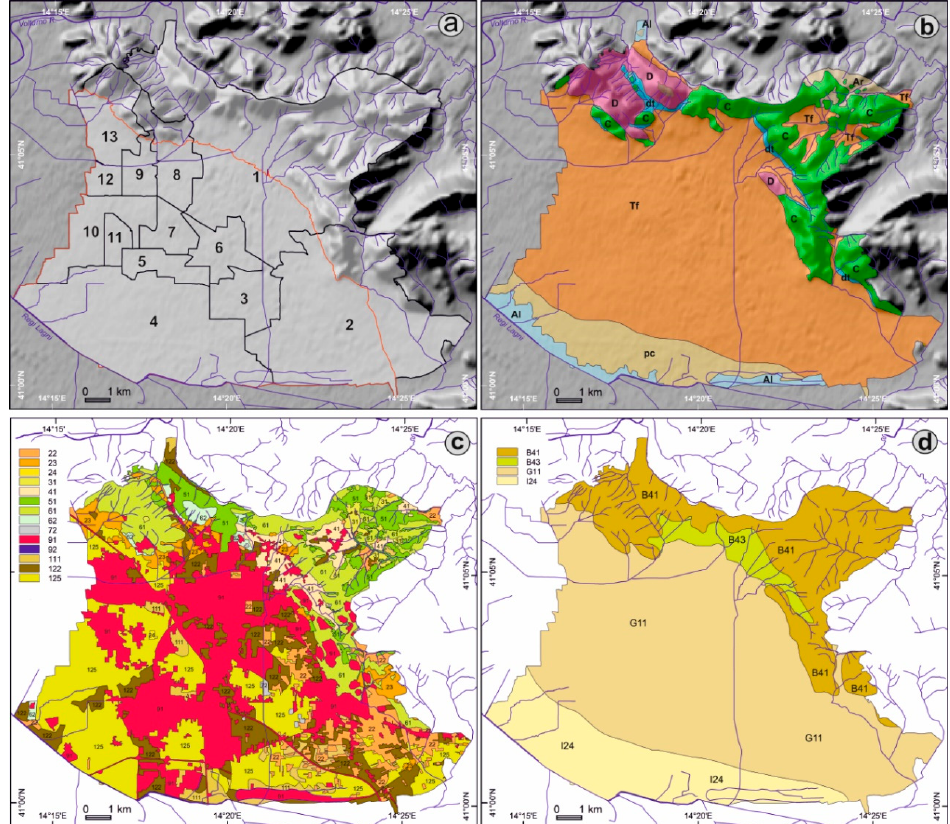
Figure 3. ( a ) Digital elevation model of the study area (Shuttle Radar Topography Mission